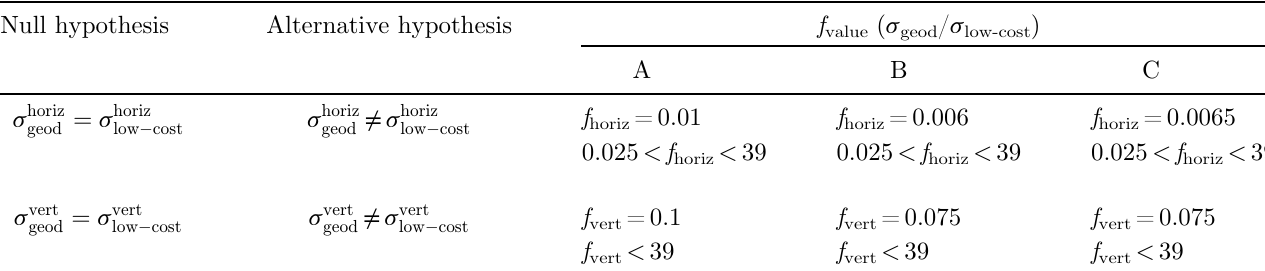
Table 14. Statistical evaluation of measurement uncertainty for the long baseline